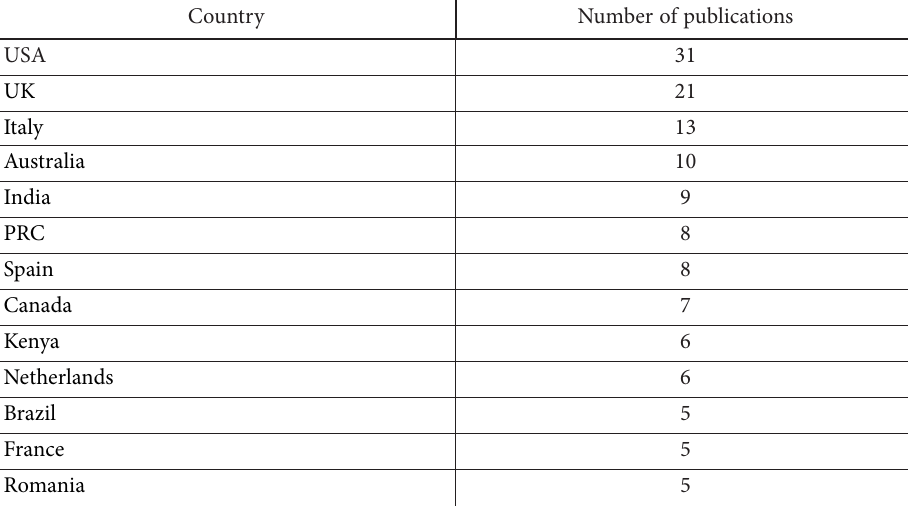
Table 3. Countries and geographic entities most engaged in the dissemination of knowledge regarding food security and short supply chains, 1990–2022